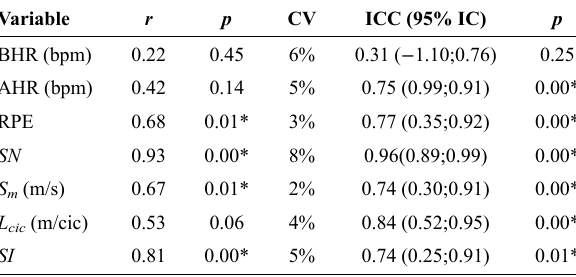
Table 2 - Intergroup and intragroup values applied to master